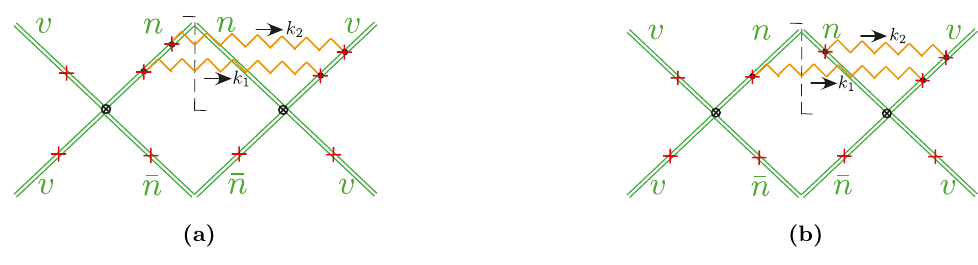
Figure 6 . Examples of real (a) and virtual (b) diagram with independent emissions contributing to the two loop soft function. Here the particle with momentum k 1 is at the scale M (cid:31) (1 k 2 is at the scale m W